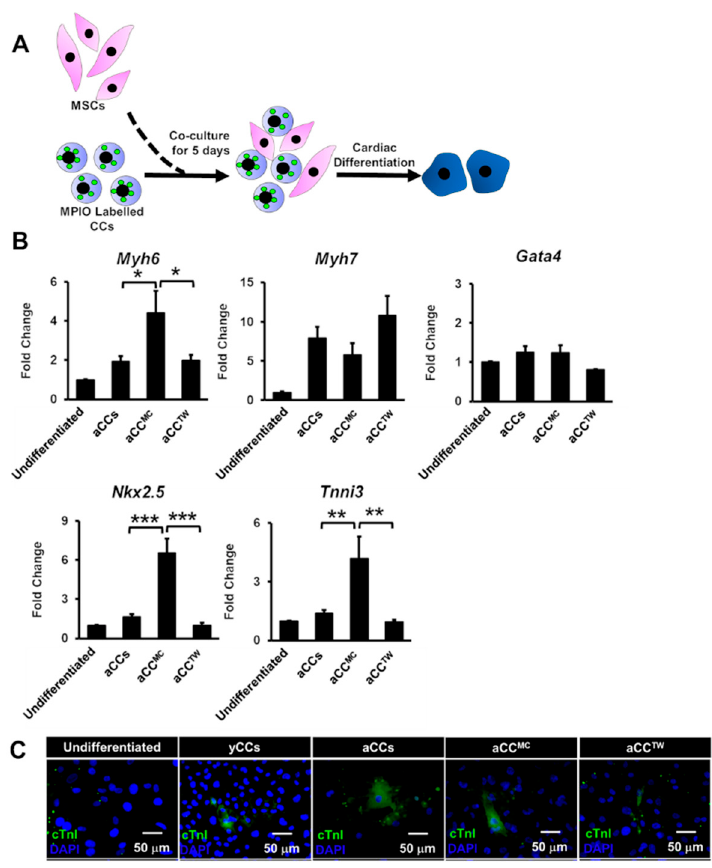
Figure 5. Co-culture with MSCs is capable of improving the cardiomyocyte di ff erentiation of aCCs without CC reisolation. ( A ) Schematic diagram showing the cardiac di ff erentiation of CCs without re-isolation after co-culture with MSCs. ( B ) Cardiac gene markers ( Myh6 , Myh7 , Gata4 , Nkx2.5 , and Tnni3 ) were performed by qPCR. ( C ) Representative images of di ff erentiated cells after 21 days. cTnI was stained in green. Nuclei were stained in blue (DAPI). Scale bar = 50 µ m. All data are mean ± SEM. * p < 0.05; ** p < 0.01; *** p < 0.001. ( n = 3).